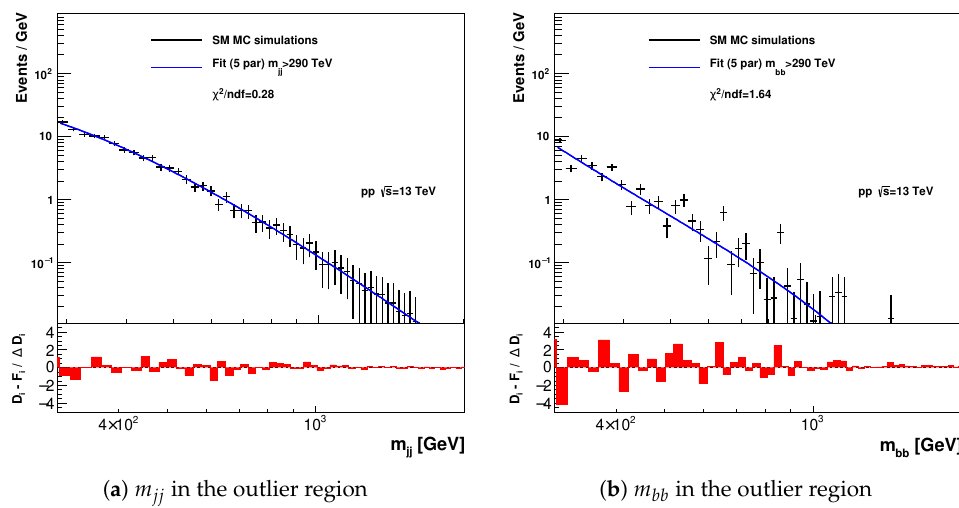
Figure 3. Invariant masses in the outlier region with ln ( Loss ) > − 6.5. The masses were reconstructed for light-favor jets and b -jets using SM Monte Carlo simulations. The blue line is the fit function (see the